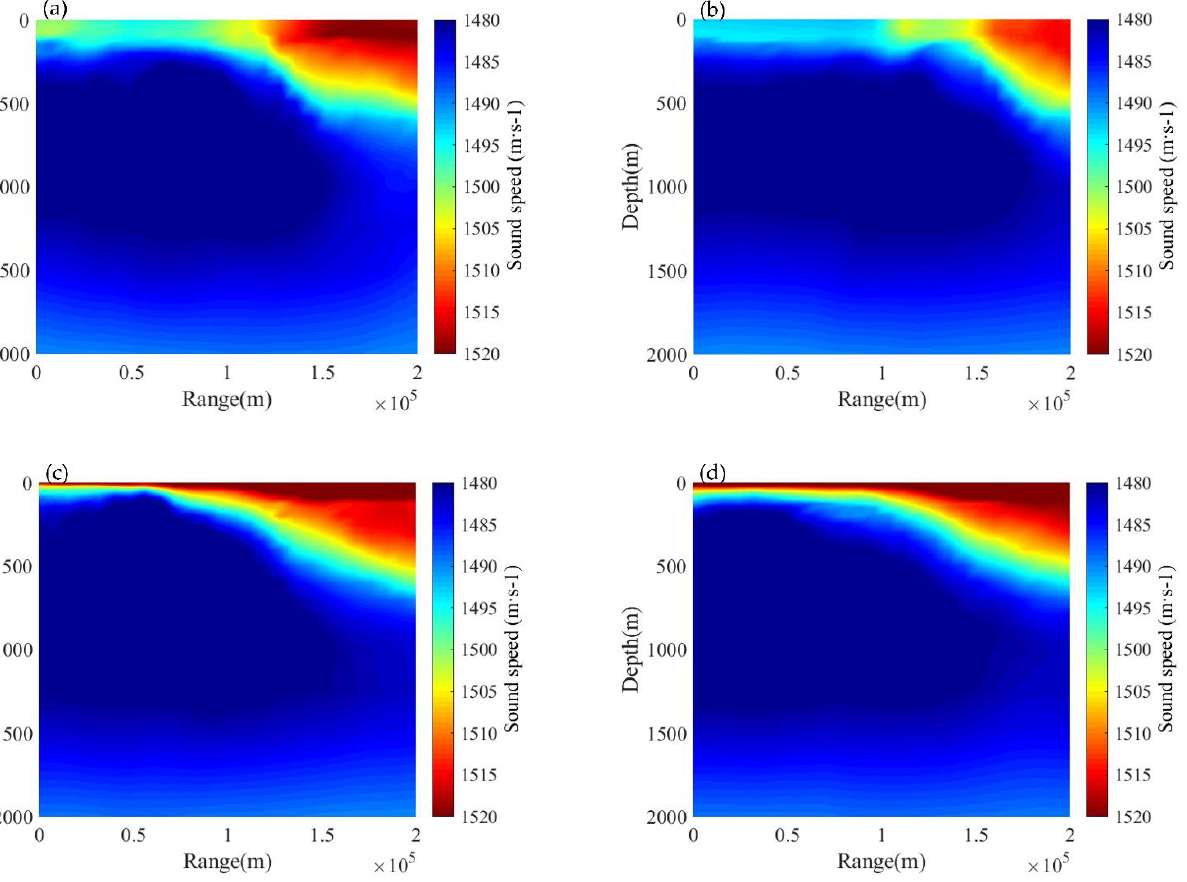
Figure 2. Sound speed distribution of the 144° E section in different periods in the ocean front environment (the depth of influence of the ocean front is relatively shallow, we showed the sound speed distribution of 0 – 2000 m to better observe the ocean front): ( a ) 1 January 2019; ( b ) 1 February 2019; ( c ) 1 July 2019; ( d ) 1 August 2019. The sound speed distribution in the sea area was calculated through Equation (1). Due to the difference in time, the position and intensity of the KEF also vary greatly.